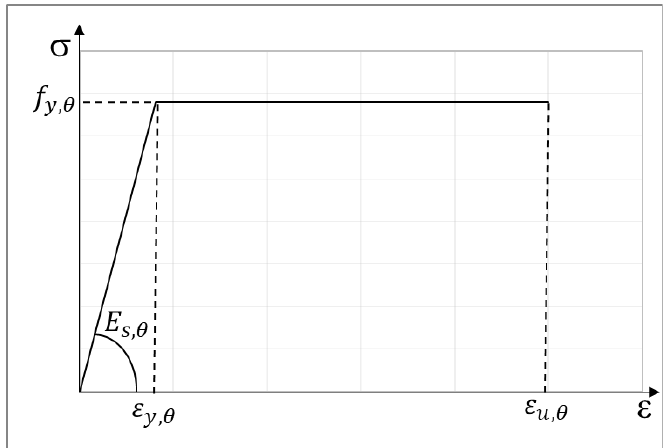
Figure 4. Generic perfect elastoplastic bilinear constitutive law for steel in function of the